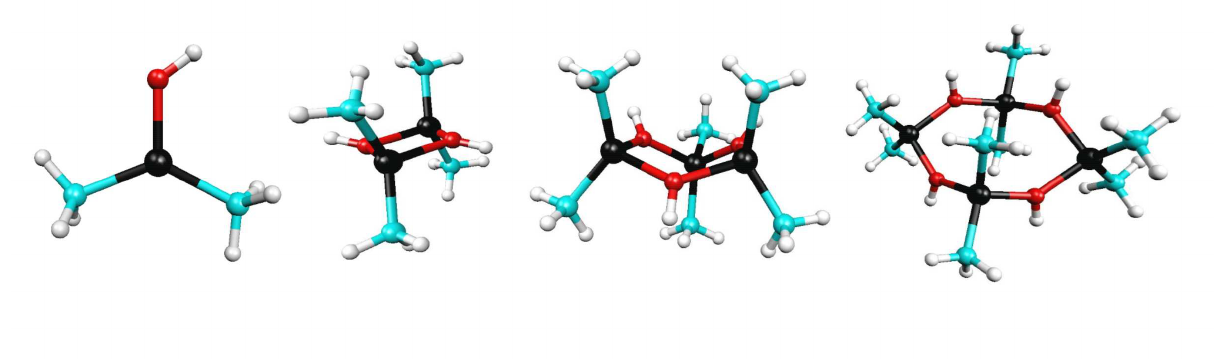
Ga( m -OH) oligomer structures optimized by DFT (B3LYP/TZV). 2 ), dimer (C ), trimer (C ), and tetramer (C s 2h s